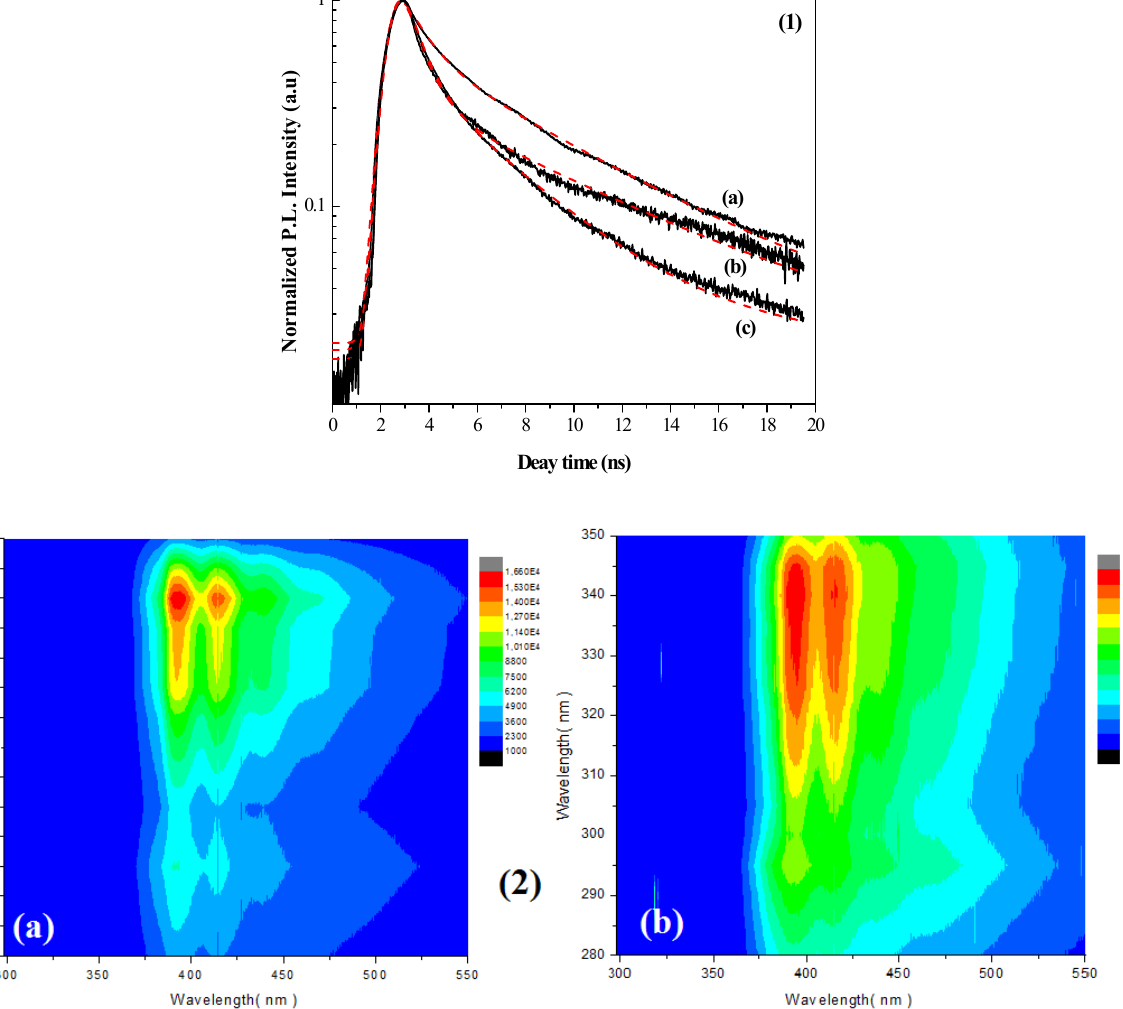
Figure 8. ( 1 ) PL decay OVK ( a ), OVK/SWCNTs in chloroform ( b ), and OVK/SWCNTs in chlorobenzene ( c ) (—: experimental; ( . . . .): theoretical). ( 2 ) PL cartography of OVK/SWCNTs in chloroform ( a ) and in chlorobenzene ( b ).